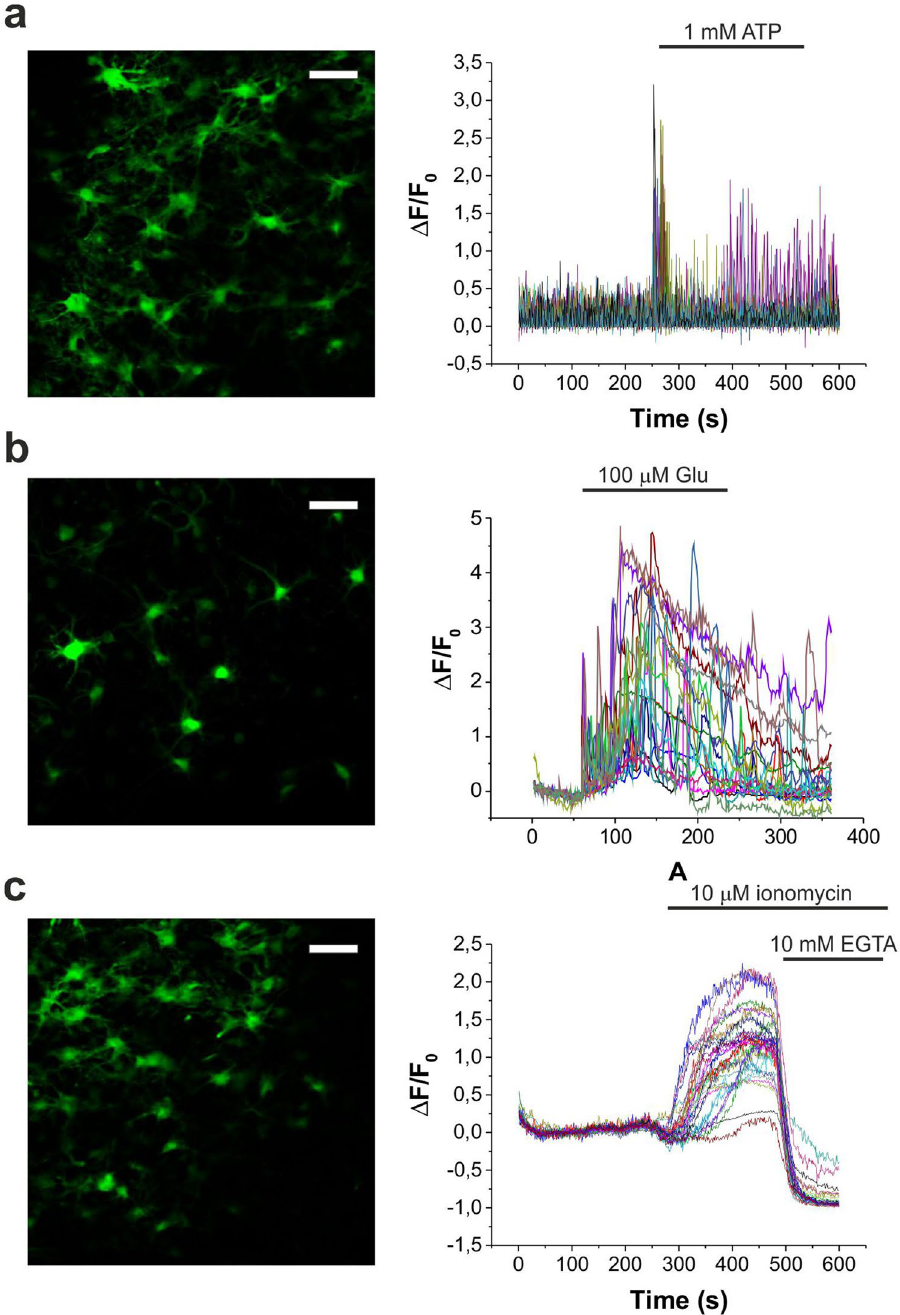
Figure 2. Pharmacological characterization of GCaMP2 response in organotypic cortical slices in vitro . ( A–C ) Representative fluorescent intensity changes of CAG-GCaMP2 in response to 1 mM ATP ( A , n = 3), 100 μ M Glu (B , n = 3 ) and 10 μ M ionomycin without and with 10 mM Ca 2 + chelating ethylene glycol tetraacetic acid (EGTA) (C , n = 3). Scale bars: 50 μ In vitro characterization of GCaMP2 response to pharmacological manipulation. To evaluate the potential of GCaMP2 expressing transgenic rats to monitor changes in intracellular Ca 2 + concentration, organo- typic cortical and hippocampal slices were subjected to pharmacological tools inducing [Ca 2 + ] increase in both neurons and astrocytes (Fig. 2, Supplementary Fig. 2, Supplementary Information Movie 1–3). Bath application of ATP triggered a significant increase in GCaMP2 fluorescence in all cells, which gradually declined thereafter (Fig. 2A). 100 µ M glutamate (Glu) induced repetitive Ca 2 + transients (Fig. 2B) in both soma and dendrites (see also Supplementary Information Movie 2). Finally, application of the Ca 2 + ionophore ionomycin resulted in pro- gressive increase in GCaMP2 fluorescence corresponding to accumulation of intracellular Ca 2 + . The fluorescence increase could be reversed by application of the Ca 2 + chelator ethylene glycol tetraacetic acid (EGTA) (Fig. 2C).